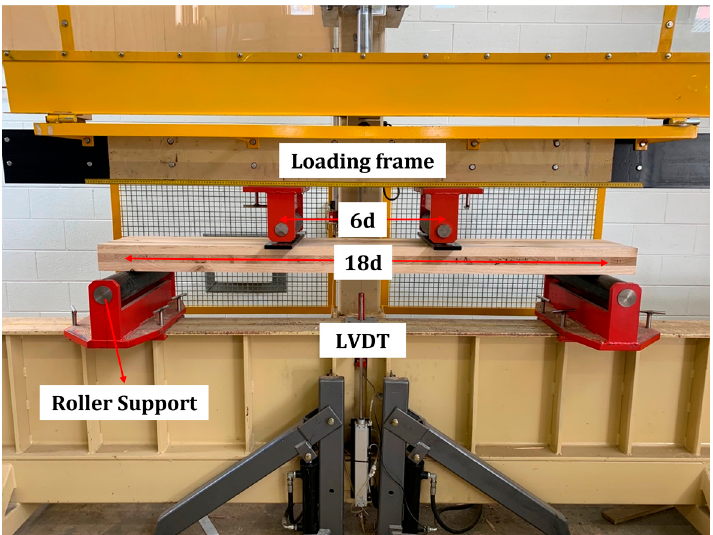
Figure 1. Setup of the static bending